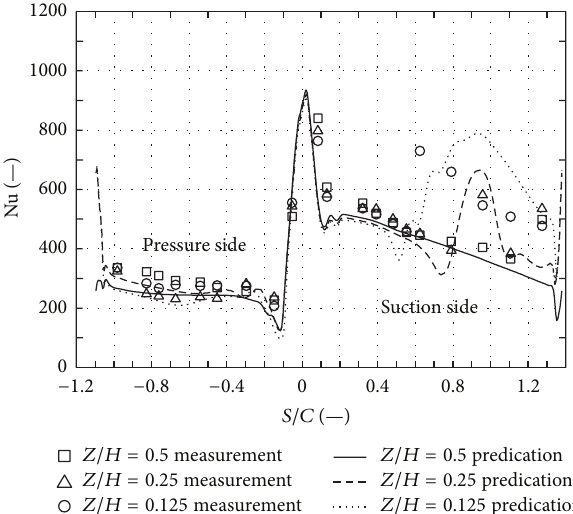
Figure 9: Blade static pressure coefficient at different spanwise locations and at Re =